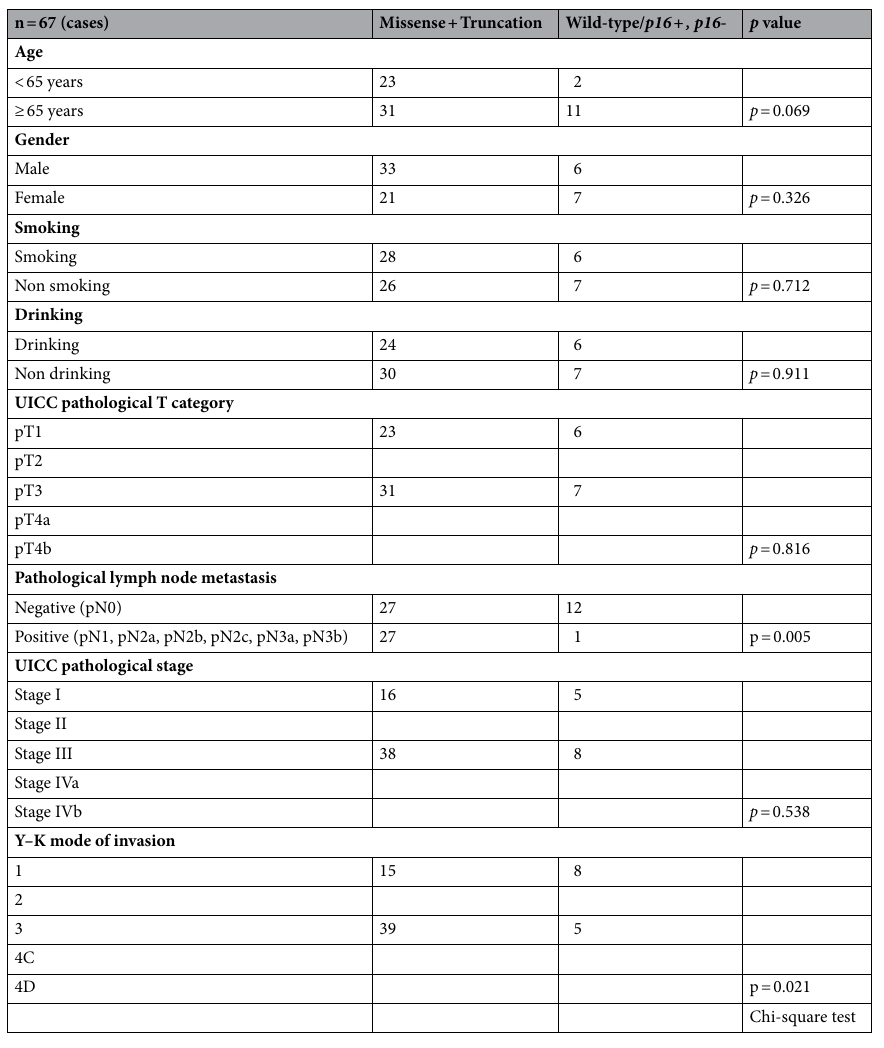
Table 4. Characteristics of the patients and p53 mutational spectrum (Statistical